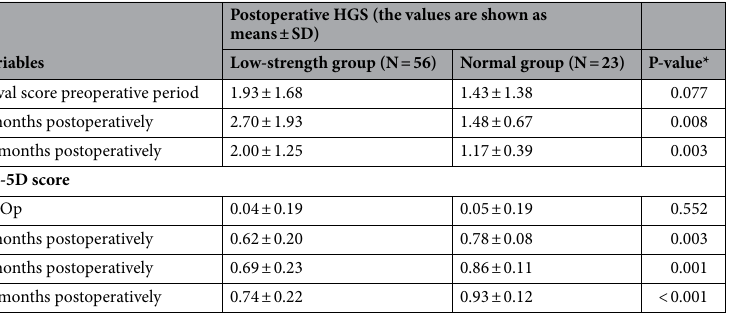
Table 5. Comparison of functional outcomes between the “low strength” group and “normal” group using postoperative HGS. EQ-5D European Quality of Life Five Dimension, HGS handgrip strength. *Mann– Whitney U test.